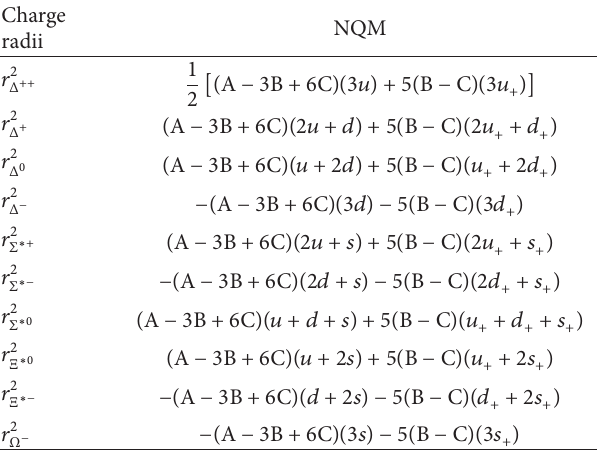
Table 2: Charge radii of decuplet baryons in NQM in terms of GPM